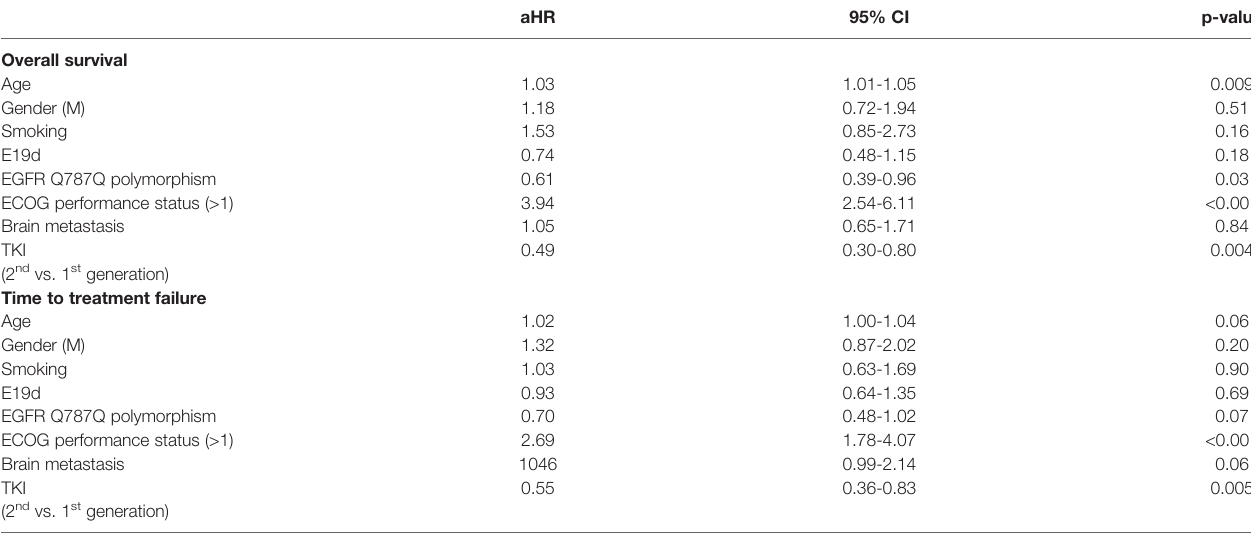
TABLE 2 | Adjusted hazard ratios (aHRs) for EGFR Q787Q polymorphism and other covariates in EGFR-mutated patients treated with TKIs.